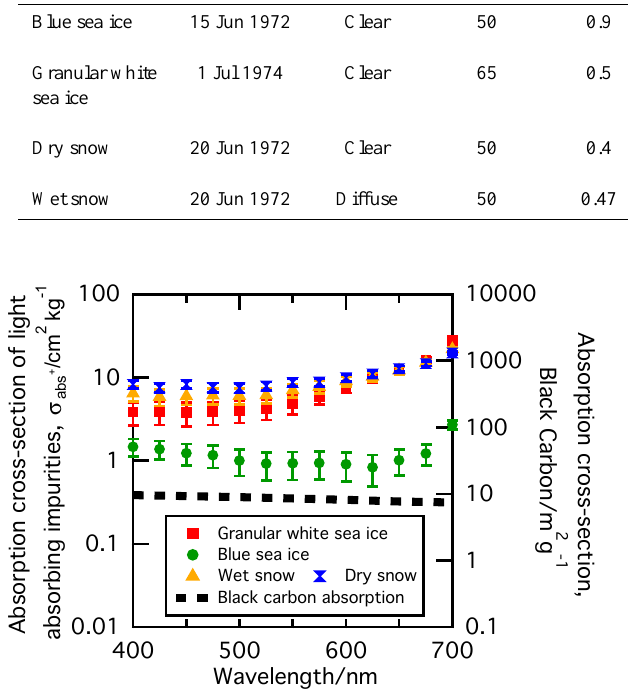
Table 1. Properties and measurement conditions of the snow and sea ice used in the study presented here. Measurement date, sky conditions, solar zenith angle, density, albedo and extinction coefficient are all from Grenfell and Maykut (1977). The values of the scattering cross- sections are calculated from the albedo and extinction coefficient data. Snow/sea ice Measurement Sky Solar zenith Density/ Figure Figure Maximum Asymmetry Scattering type date conditions angle/ ◦ gcm − 3 (albedo) (extinction e -folding parameter, cross-section coefficient) depth/m ( g ) ( σ scatt )/ m 2 kg − 1